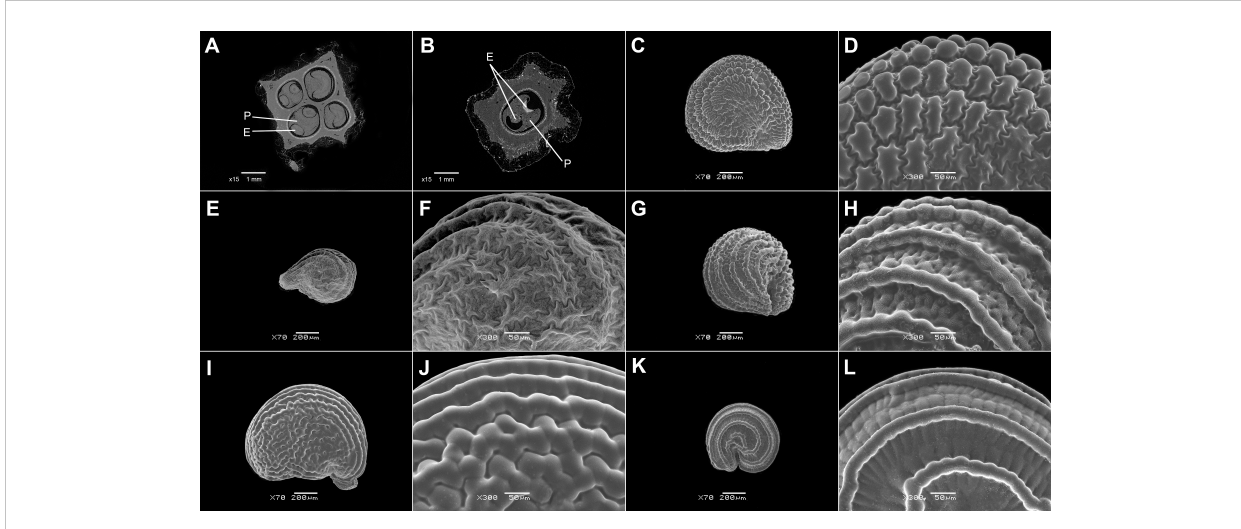
FIGURE 4 SEM micrographs or tomograms of selected Aizooideae species. (A) A tomogram of a Tetragonia echinata fruit with four visible seeds, (B) a tomogram of a Tetragonia saligna nut-like fruit, (C, D) a seed of Gunniopsis papillata , (E, F) a seed of Gunniopsis calva , (G, H) a seed of Aizoanthemopsis hispanica , (I, J) a seed of Aizoon paniculatum , and (K, L) a seed of Aizoanthemum mossamedense . Magni fi cation: (A, B) 15×; (C, E, G, I, K) 70×; (D, F, H, J, L) 300×. P, perisperm; E, embryo.